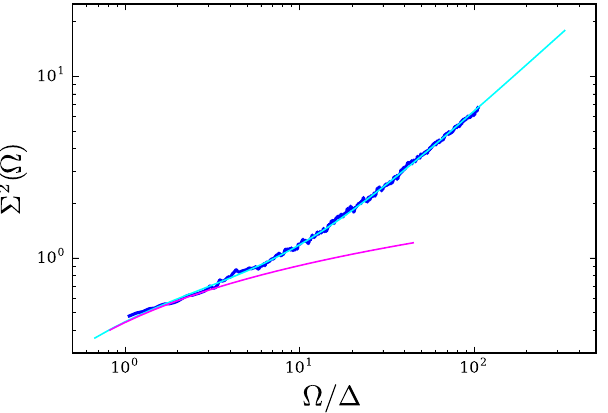
Figure 3. Blue dots: level number variance Σ Ω ( ) 2 in a sample 200 × 200 with 20% of the pinned sites for E ≈ 3.5. The theoretical fit with g ph = 1.6 is plotted by a solid line in cyan. The RMT result is given in